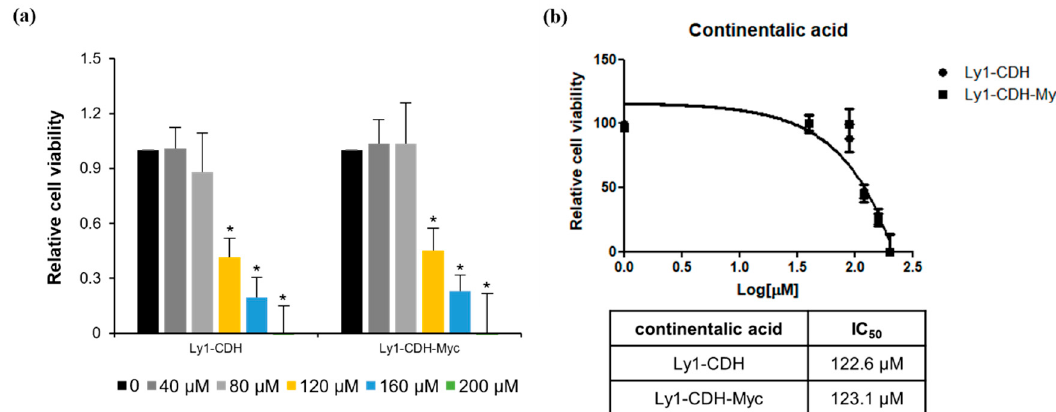
Figure 7. Continentalic acid inhibits cell survival Myc-independently. ( a ) Ly1-CDH and Ly1-CDH-Myc cells were exposed to increasing concentrations of continentalic acid for 24 h, followed by measurement of cell viability by MTS assays. Statistical significance was calculated using the two-tailed one-way ANOVA test (* p < 0.05). ( b ) The IC 50 values of continentalic acid in Ly1-CDH and Ly1-CDH-Myc cells were calculated using GraphPad Prism 5 software, which shows virtually no difference between Ly1-CDH and Ly1-CDH-Myc cells.